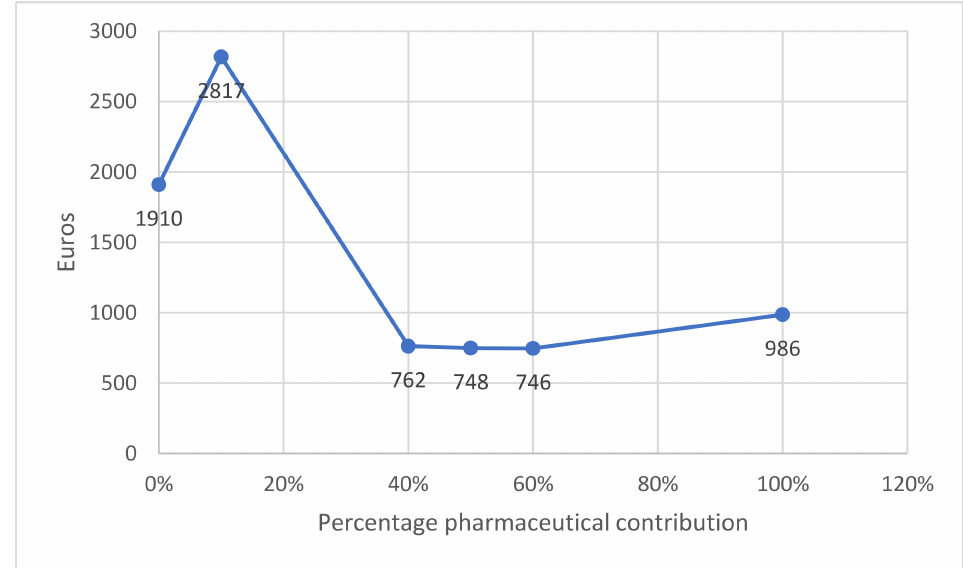
Figure 1. Relationship between pharmaceutical contribution and total costs in